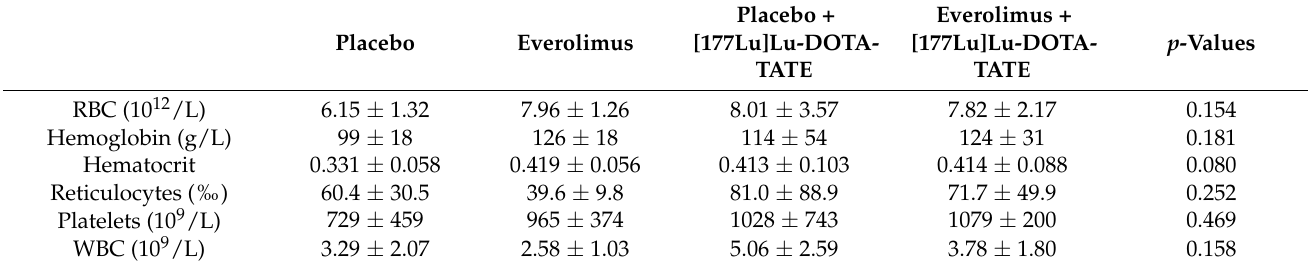
Table 1. Results of the total blood count performed at euthanasia. PRRT causes a significant increase in lymphocyte and neutrophil counts. p -values result from a two-way ANOVA of the four